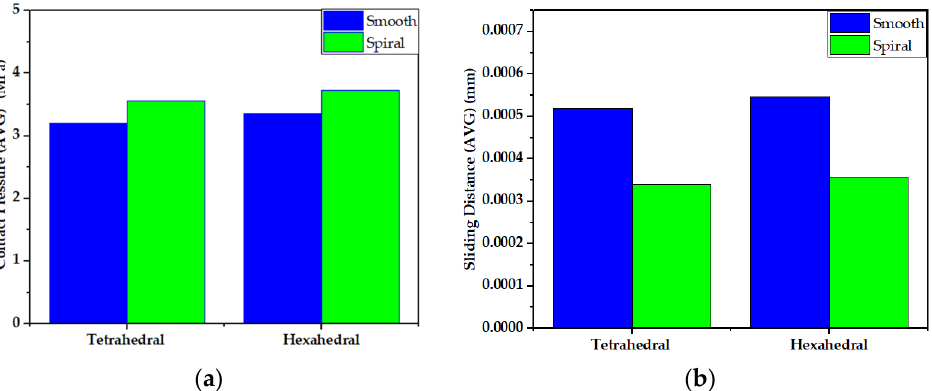
Figure 5. Impact of mesh element variation on ( a ) average contact pressure and ( b ) average sliding distance for both head-stem trunnion types.